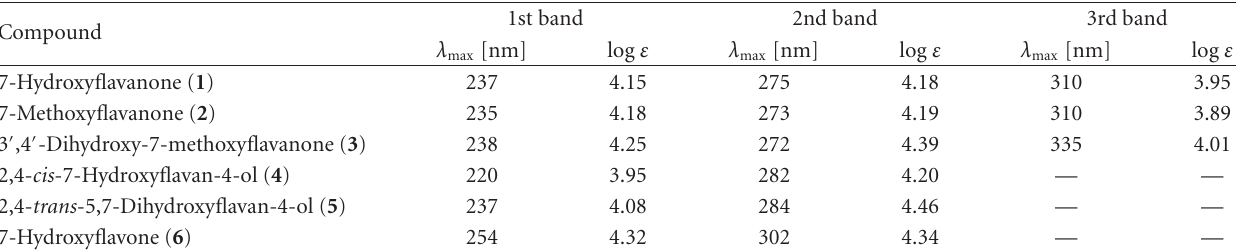
Table 5: The IC 50 values of the 7-hydroxyflavanone (1) and the biotransformation products. Substrate Product